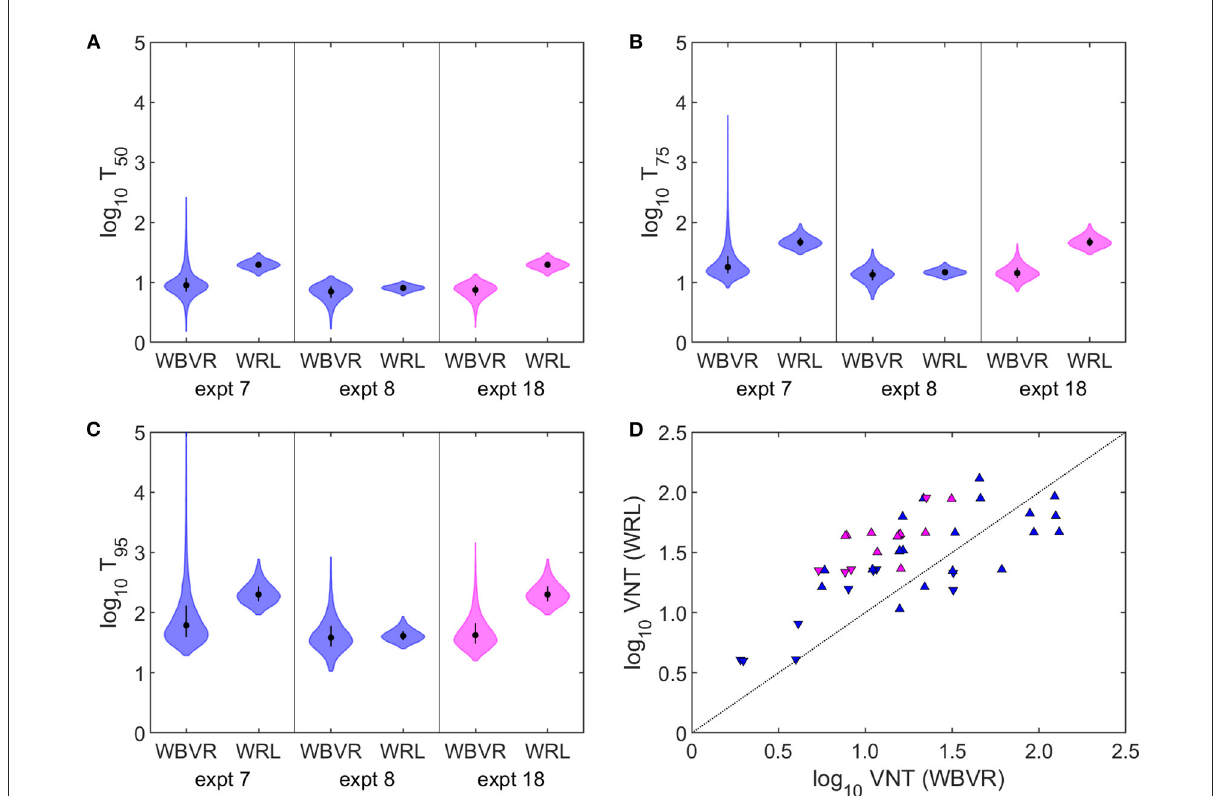
FIGURE3 Impact of inter-laboratory variation in virus neutralisation titres (VNT) on estimates of titres required for protection. (A–C) VNT required for (A) 50%, (B) 75%, or (C) 95% of cattle to be protected from challenge with foot-and-mouth disease virus estimated using VNT obtained at WBVR or WRLFMD. Violin plots show the median (circle), interquartile range (error bar), and density (shape) for the posterior distribution. (D) VNT results obtained at WBVR and those obtained at WRLFMD in this study. Symbols indicate protection status of the animal: up-triangle (protected), down-triangle (not protected). The dotted line indicates equality. In all panels colour indicates serotype: A (blue) and SAT 2 (magenta). Details of the three experiments (7, 8, and 18) are shown in Table 1.